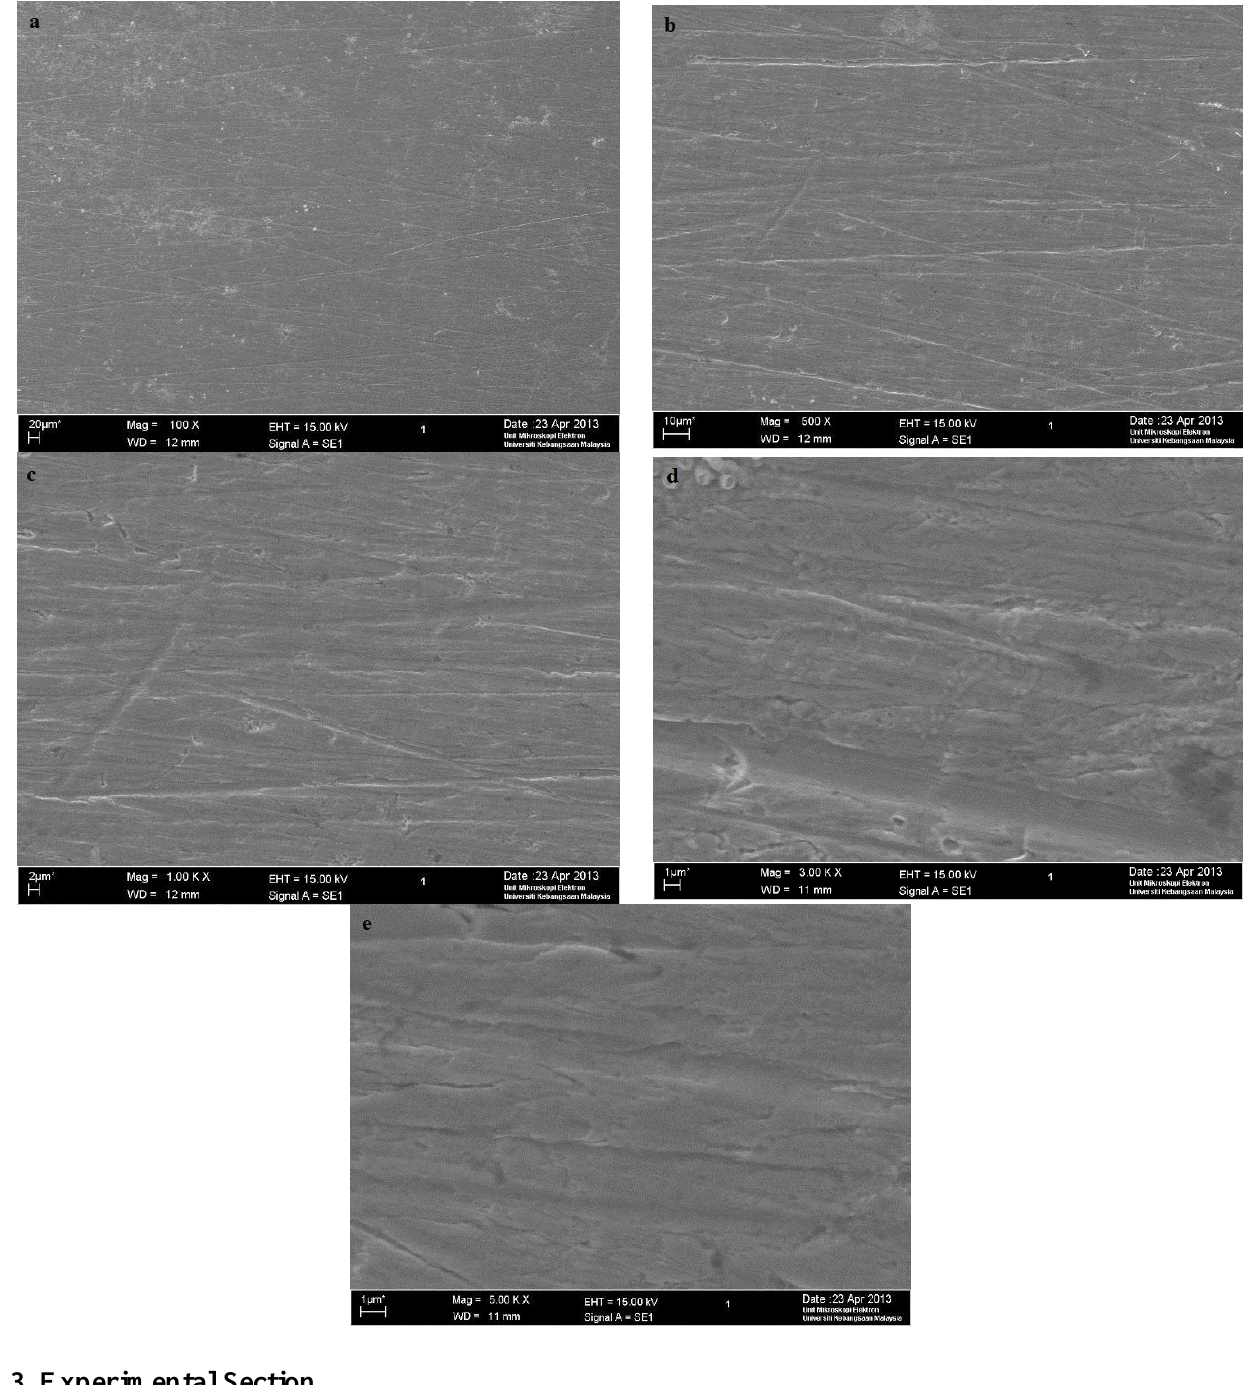
SO with 0.25 mM of 2 4